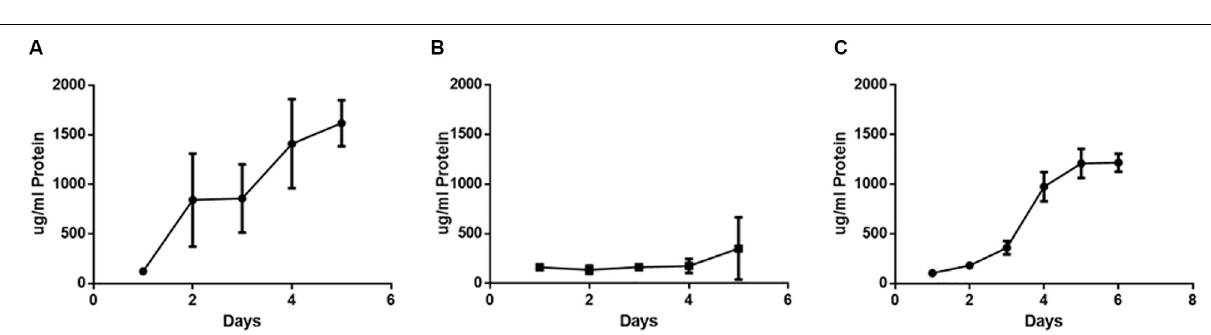
FIGURE 5 | Changes in protein content during polymicrobial biofilm growth. (A) Single species H. somni strain 2336 biofilm grown for 5 days. (B) Single species P. multocida strain C0513-P5 biofilm grown for 5 days. (C) Polymicrobial biofilm of H. somni grown for 3 days, P. multocida added, and growth continued for an additional 3 days. The protein content of the biofilms was determined by BCA assay. All experiments were performed in triplicate in three different experiments (9 datum points